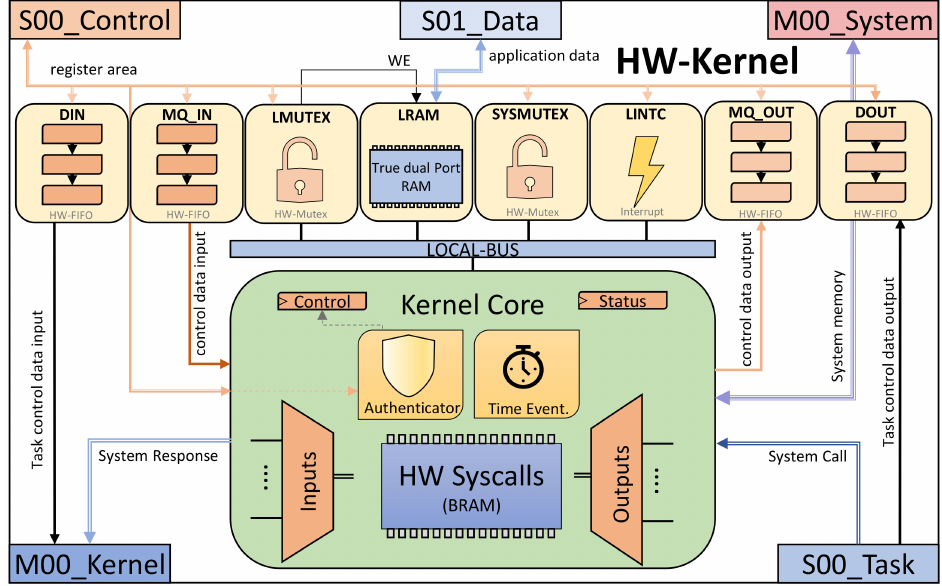
Figure 3. Hardware Kernel simplified